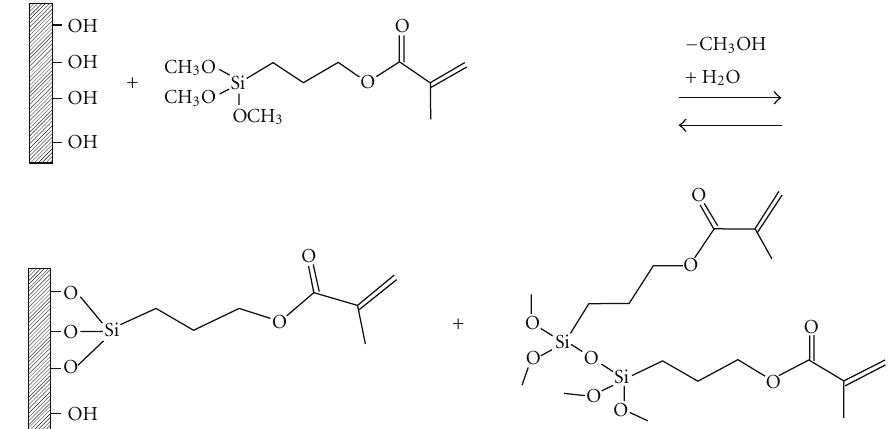
Scheme 2: Schematic presentation of grafting of 3-metacryloxypropyltrimethoxysilane (MPS) to OH-groups of the Sb:SnO 2 particle surface and formation of MPS oligomers.